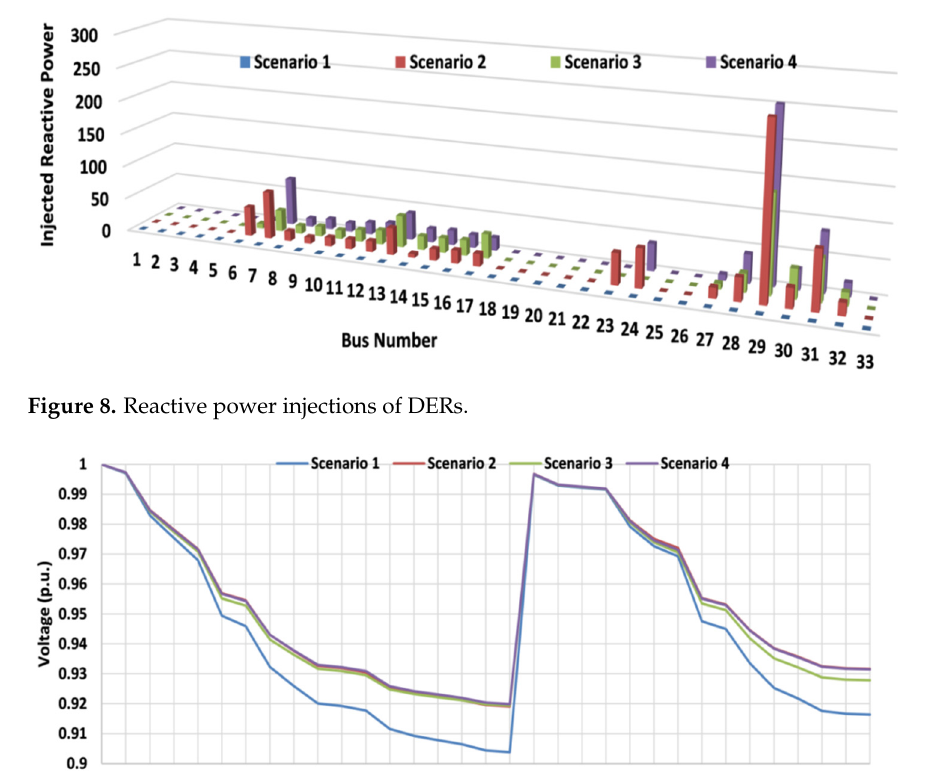
Figure 7. Convergence curve of the scenario 2.